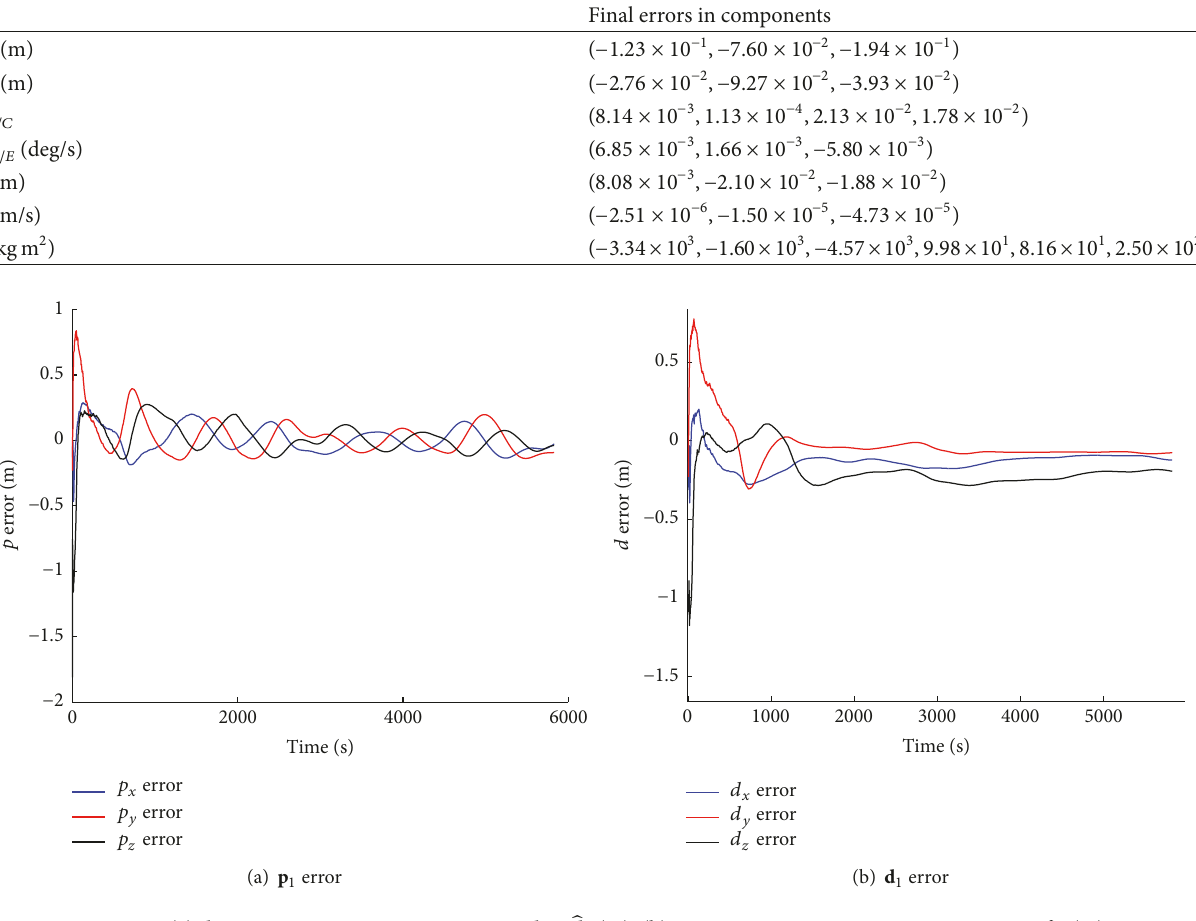
Figure 6: (a) d 1 estimation errors in components: d 1 −